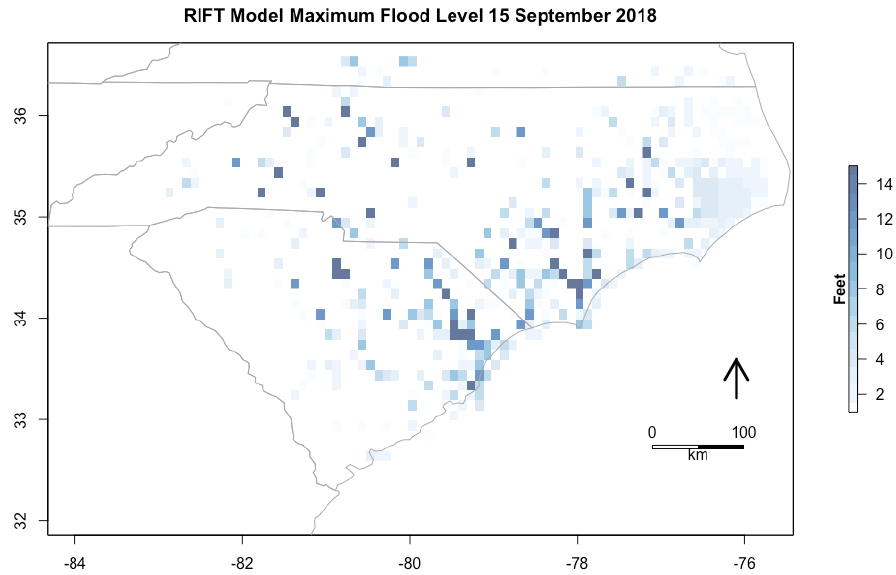
Figure 4. Raster visualization of flood